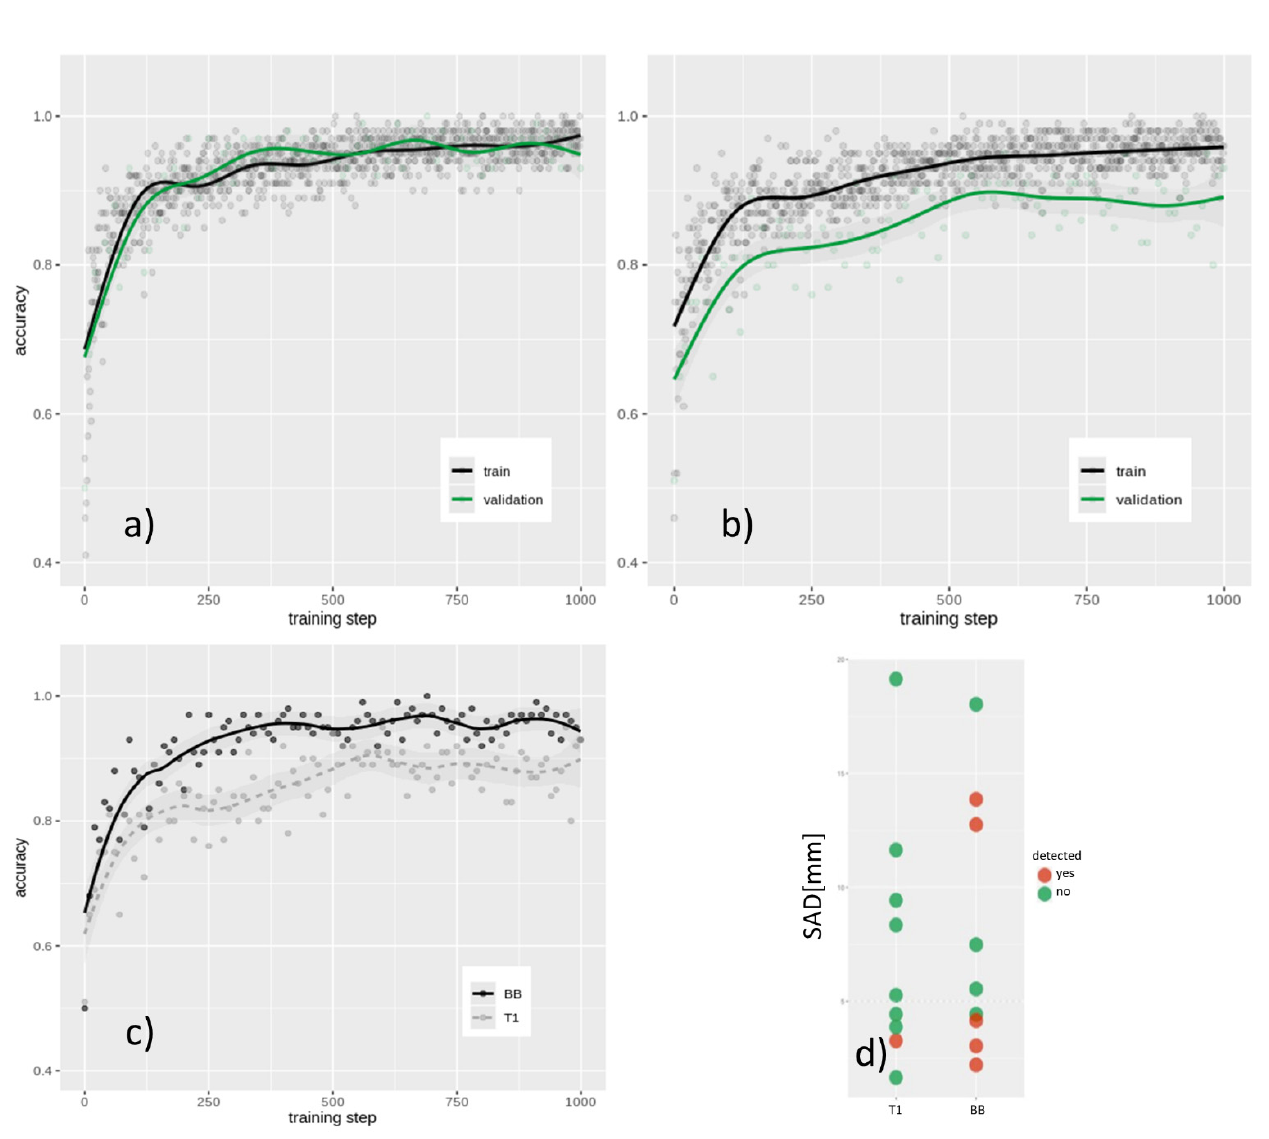
Figure 4. Training and validation accuracy of the ( a ) BB and ( b ) conventional T1 data sets; ( c ) validation accuracy of both data sets in comparison; ( d ) metastasis size of the detected lesion in the holdout validation analysis by corresponding set.